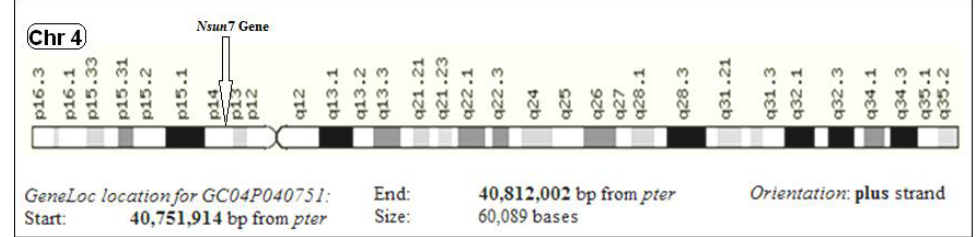
Fig. 1. Schematic drawing of the Nsun7 gene position.